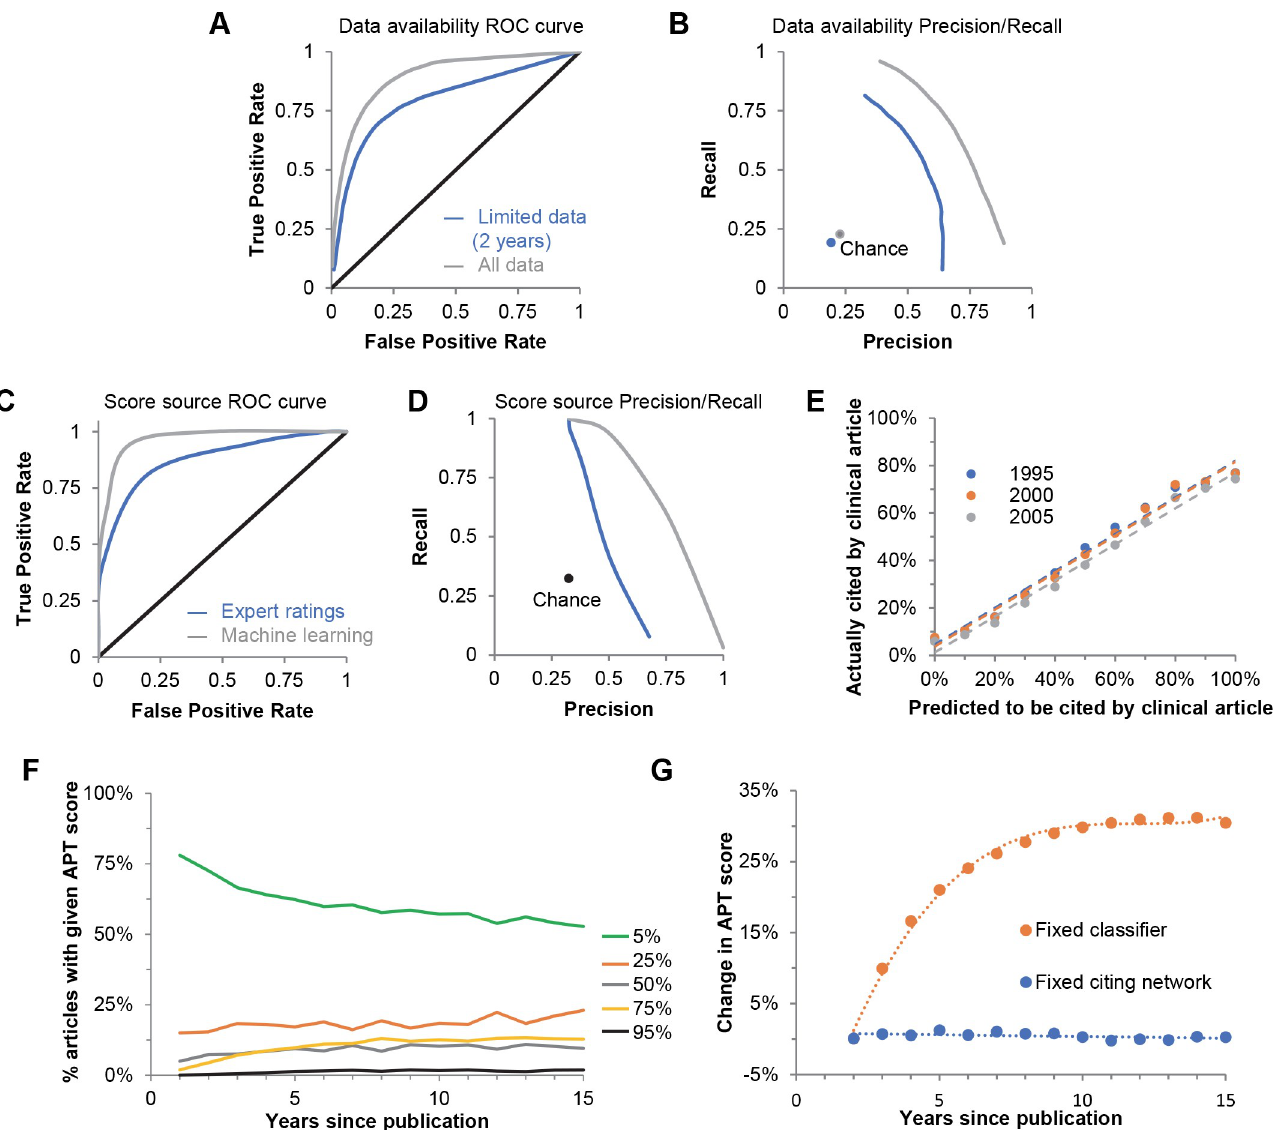
Fig 3. Validation of machine learning predictions. (A, B) Prediction performance for citation data limited to the first 2 years post publication (blue line) or including all data available at the time of the analysis (grey line). (A) Receiver operating characteristic curve to assess performance of predictions (chance, black line). AUC: 0.80 (blue line) and 0.90 (grey line). (B) Precision-recall graphs to assess performance (chance, blue or grey dot). Accuracy: 84% (blue line), 85% (grey line); accuracy is defined as the percent of test set predictions that were correct. F1 scores: 0.56 (blue line), 0.68 (grey line). (C, D) Postpublication peer-review scores from Hutchins and colleagues ([18]; blue line) were compared with machine learning prediction scores (grey line); reviewers rated clinical impact on a scale of 1–5 ( N = 985 rating scores). (C) Receiver operating characteristic curve to assess performance of expert scores and machine learning predictions (chance, black line). AUC: 0.64 (blue line) and 0.85 (grey line). (D) Precision-recall graphs to assess performance. Accuracy: 69% (blue line), 81% (grey line); F1 scores: 0.52 (blue line), 0.68 (grey line). (E) Correlation between predicted and actual citations for papers published in 1995 (blue), 2000 (orange), and 2005 (grey), using 2 years of citing network data for predictions. Dashed lines represent a linear regression; the slope and r 2 values, respectively, for each year are as follows: 1995 (0.775, 0.985), 2000 (0.779, 0.984), and 2005 (0.759, 0.988). (F) Percent of articles published in 2000 falling into each of the 5 APT score bins over time. (G) APT scores are assigned based on new information entering the citing network of individual papers. At increasing time intervals post publication, the change in APT score was determined either for classifiers trained on data available in each year (blue) or for a fixed classifier trained on the growing citing networks (orange). APT, Approximate Potential to Translate; AUC, area under the curve; ROC, receiver operating